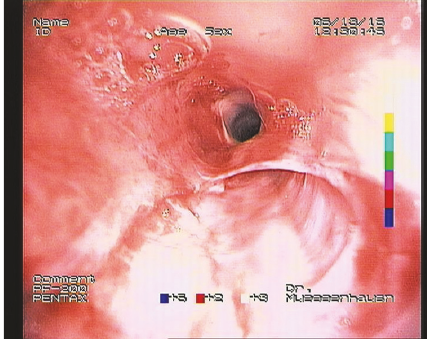
Figure 4: Endoscopic view of the esophagus. The balloon catheter can be seen in place, fully dilated.